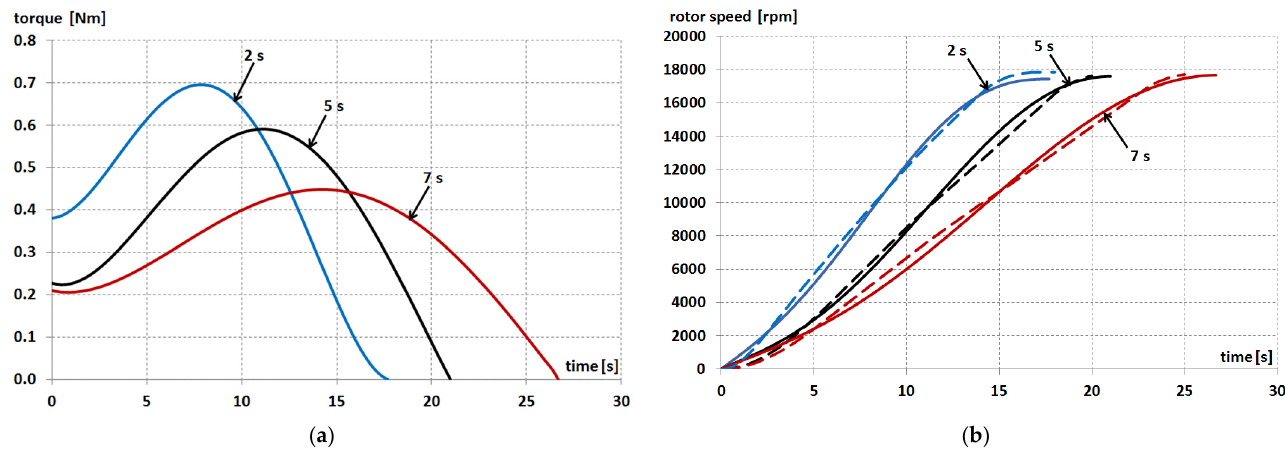
Figure 12. Measured waveforms of dynamic electromagnetic torque ( a ) and measured (solid line) and calculated (dashed line) rotational speed ( b ) at motor frequency starting with an initial voltage equal to zero for different frequency rise times, for the motor with additional inertia mass ( J = 0.00454 kg m 2 ).